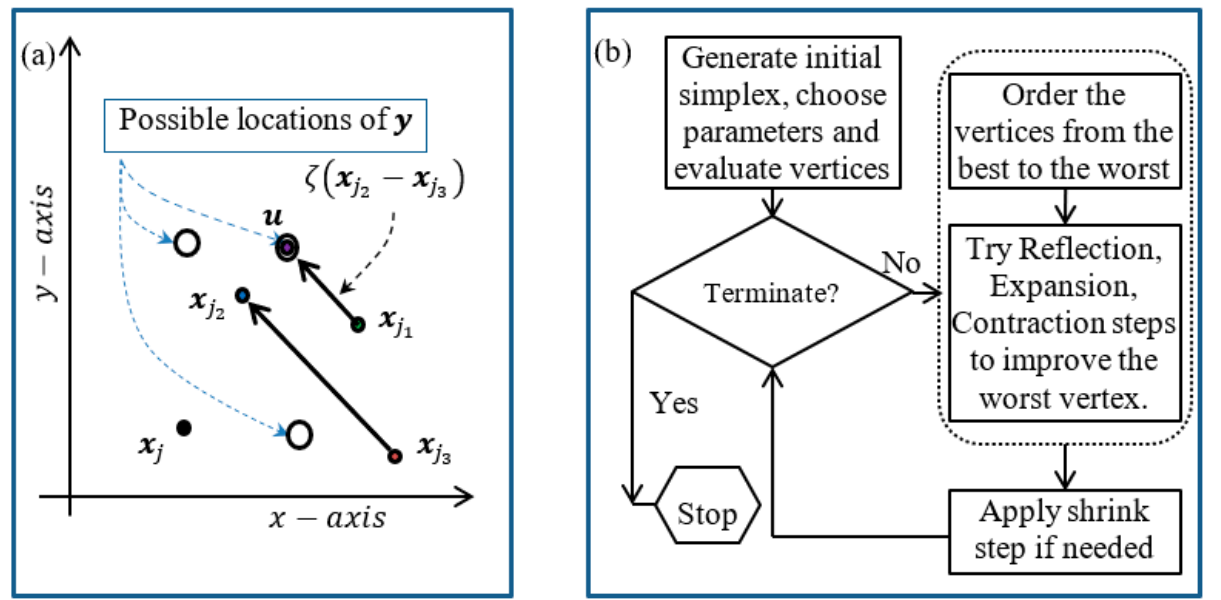
R 2 ( b ) Schematic diagram of NMS Figure 2. ( a ) DE based exploration in ℝ (cid:2870) ( b ) Schematic diagram of NMS method. Figure 2. ( a ) DE based exploration in